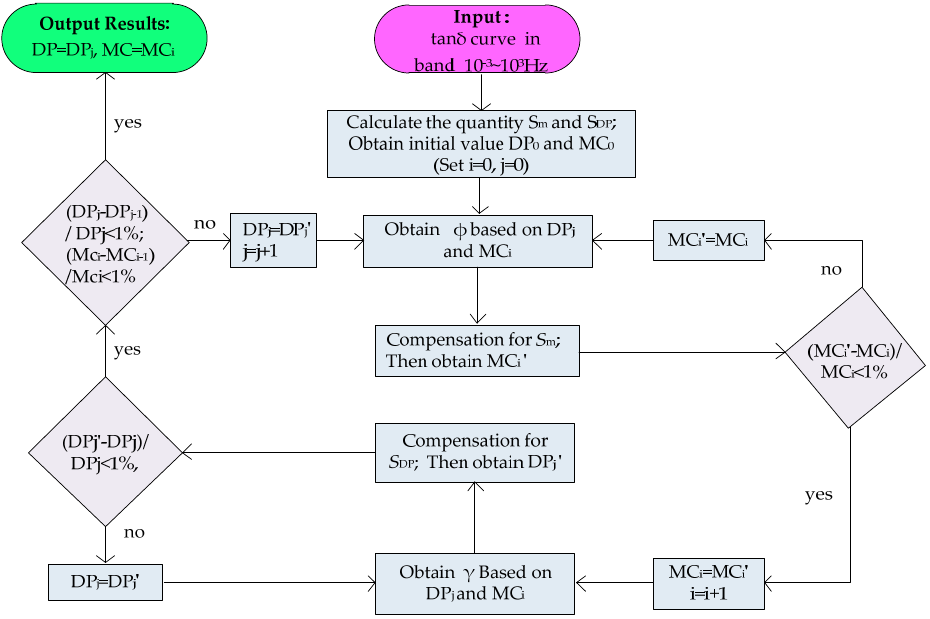
Figure 9. The flow for condition assessment of oil-paper insulation by Compensation factor algorithm.